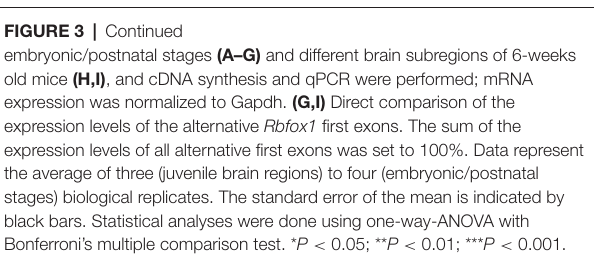
localization of the encoded RBFOX1 protein isoforms (Lee et